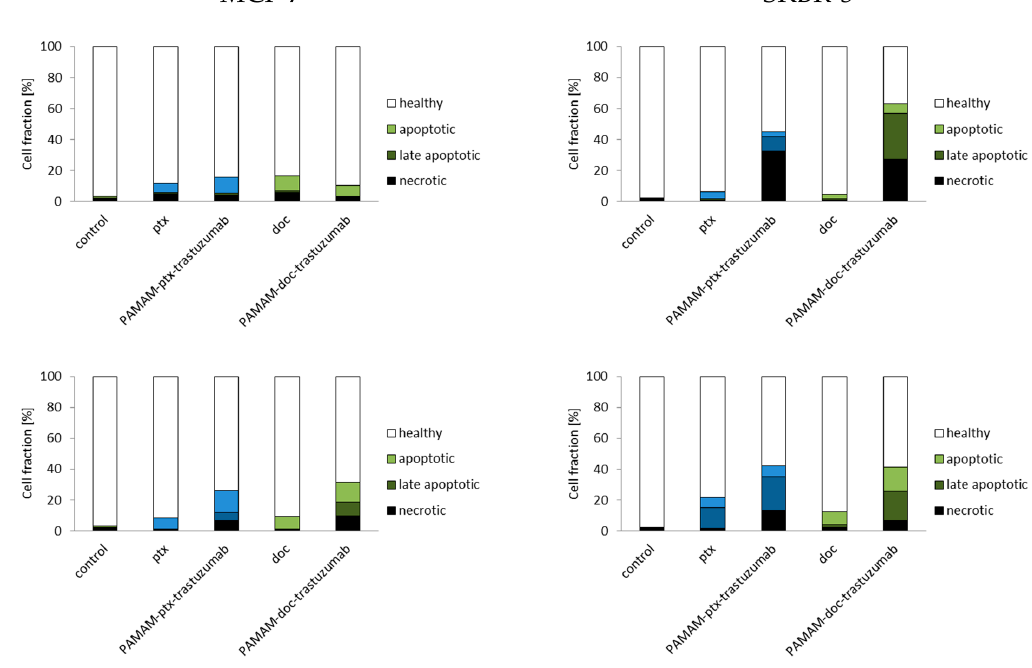
Figure 4. Fractions of apoptotic and necrotic cells after 3 and 24 h incubation periods with the PAMAM-ptx-trastuzumab conjugate, PAMAM-doc-trastuzumab conjugate, paclitaxel (ptx) and docetaxel (doc) at a 1 µ M concentration in MCF-7 cells ( left panel ) and SKBR-3 cells ( right panel ). The results are presented as the mean ± standard deviation of three experiments.